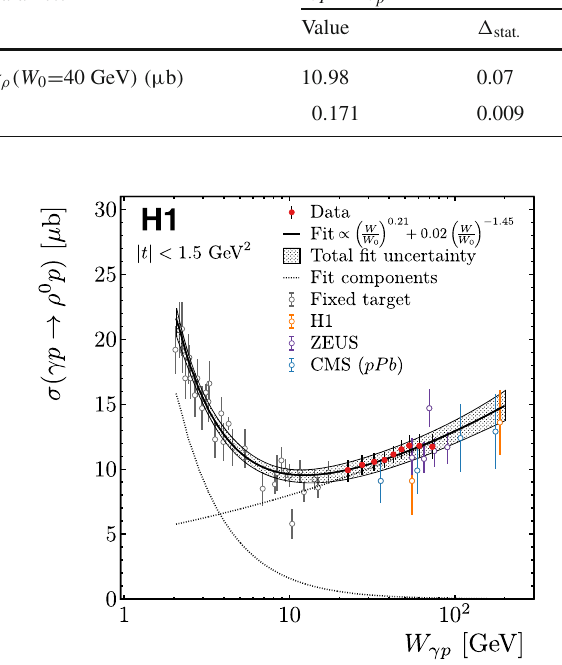
Fig. 11 Elastic ( m Y = m p ) ρ 0 meson photoproduction cross section σ(γ p → ρ 0 Y ) as a function of W γ p . The present data are compared to measurements by fixed-target [20–25], HERA [9,15,17], and LHC [26] experiments as indicated in the legend. Only total uncertainties are shown. The solid line shows the fit of a sum of two power-law functions to the fixed-target and HERA data. The respective contributions are shown as dotted lines. The fit uncertainty is indicated by a